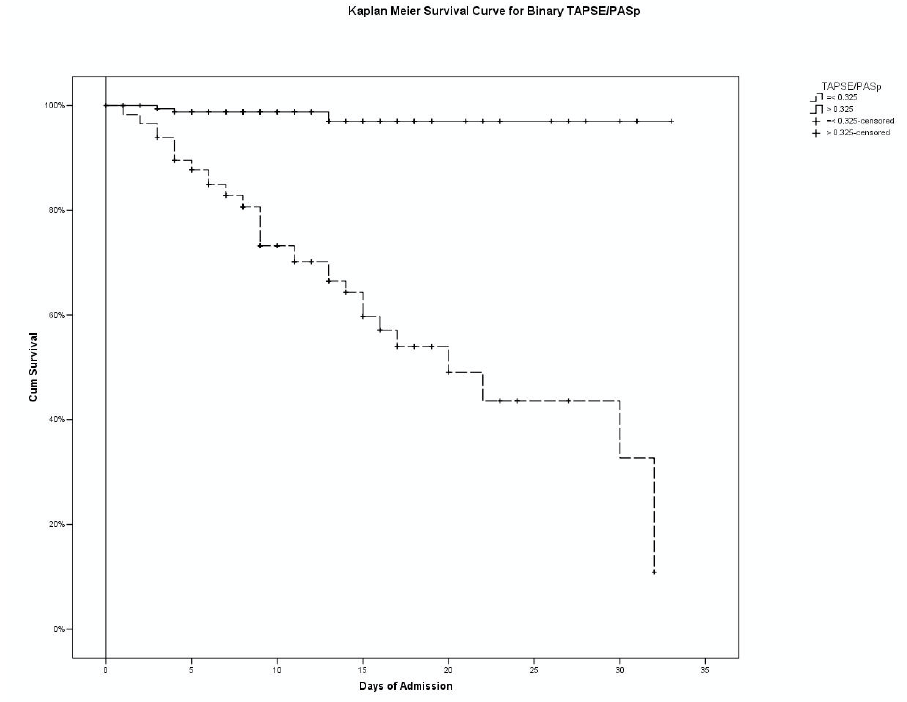
Figure 4. Kaplan–Meier curve of TAPSE/PASp, considered as a dichotomous variable ( p = 0.0001, Figure 4. Kaplan – Meier curve of TAPSE/PASp, considered as a dichotomous variable ( p = 0.0001, log-rank test). log-rank